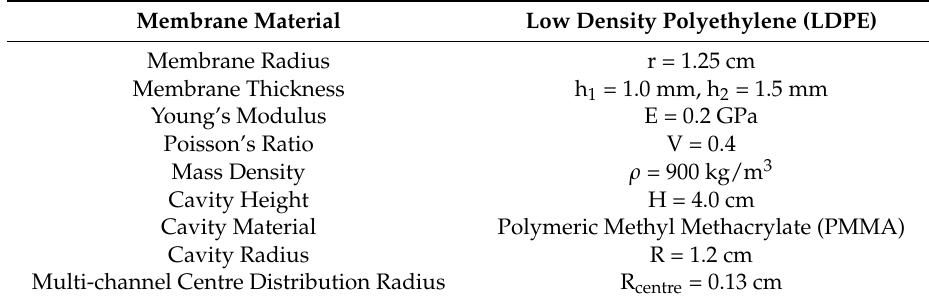
Table 1. Numerical simulation parameters.